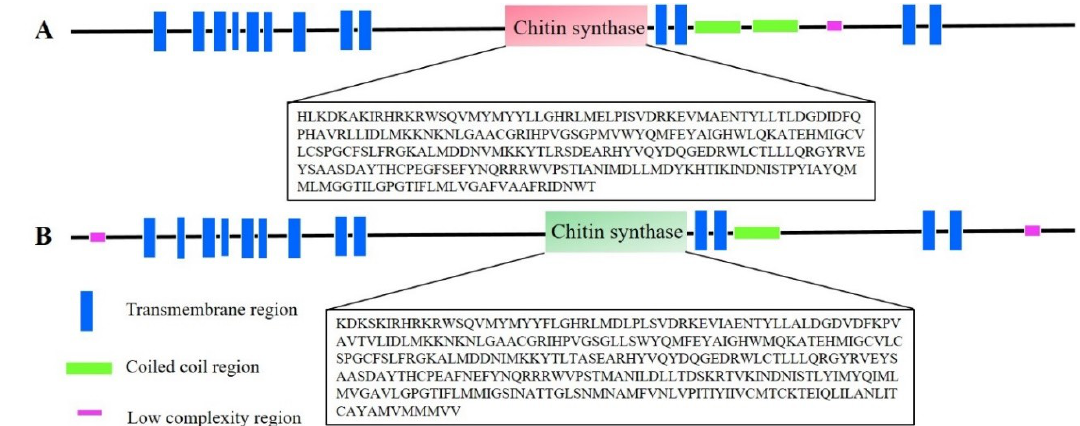
Figure 2. The predicted conserved functional domains of GpCHSA and GpCHSB. Different colors are used to mark predicted domains. The conserved functional domain of GpCHSA consists of 261 amino acids ( A ), and GpCHSB has 302 amino acids ( B ). Conserved sequences were identified using SMART (http://smart.embl-heidelberg.de/) website and indicated in boxed.